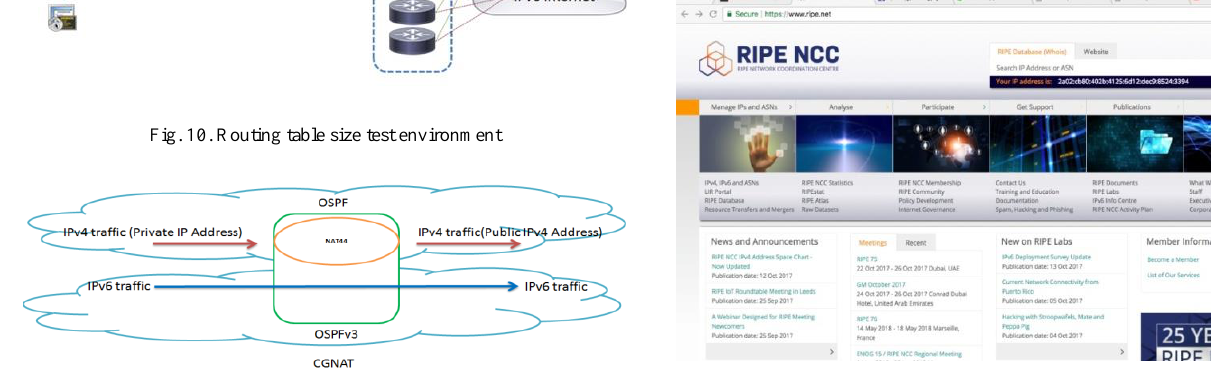
Fig. 14. Source address resolution at destination